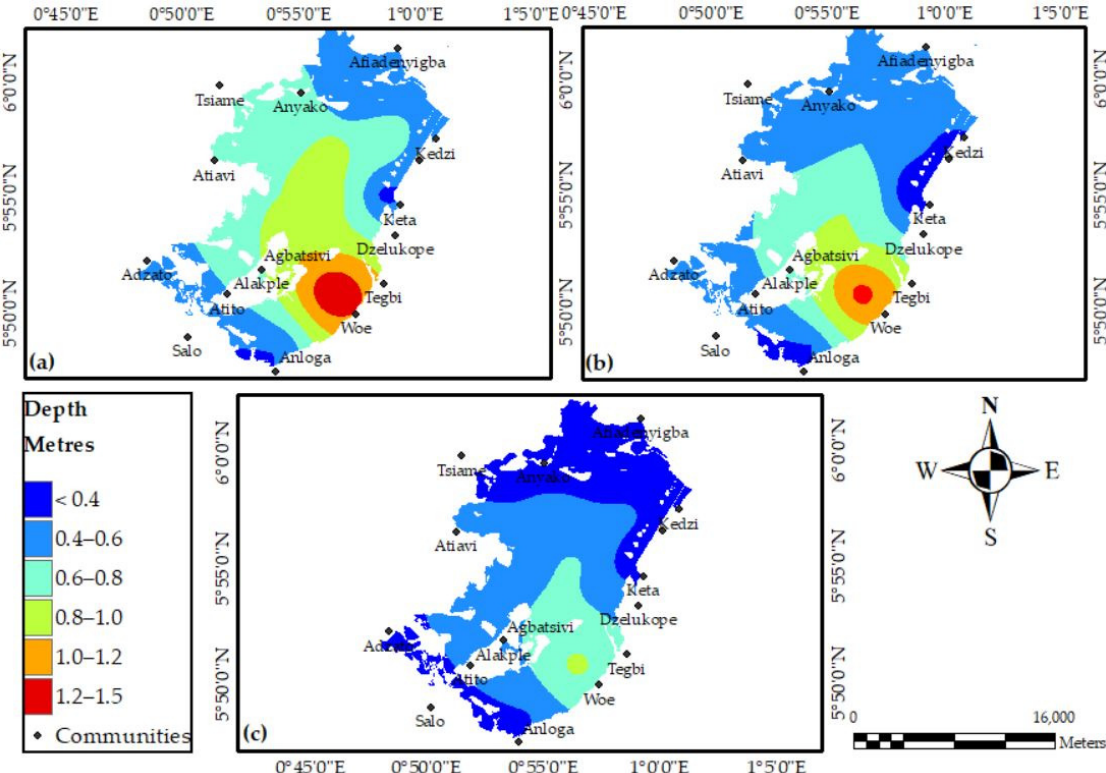
Figure 9. Maps showing the depth of Keta Lagoon in meters for ( a ) November 2020, ( b ) January 2021, and ( c ) March 2021.